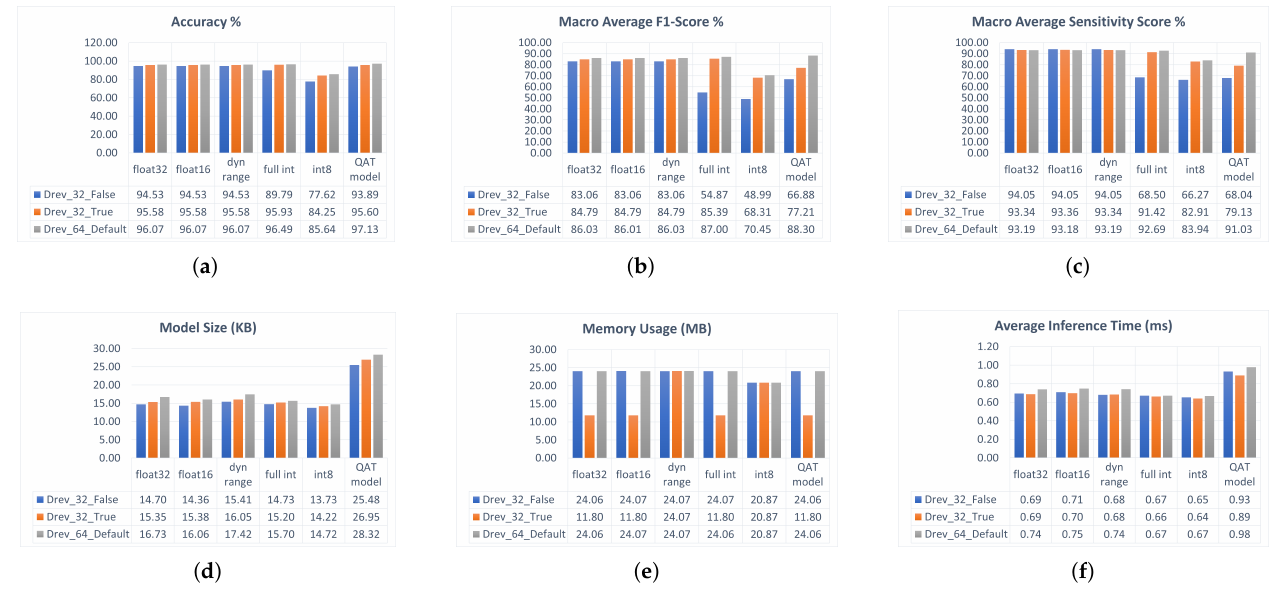
Figure 5. Testing and benchmarking results of the TFLite model variants 1,2, and 3 on the